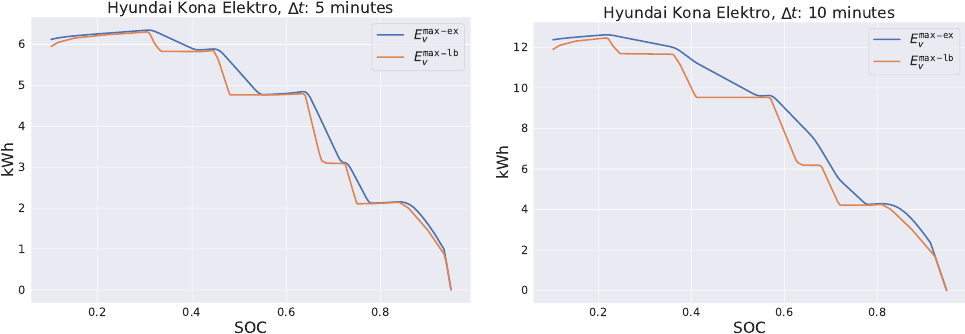
Figure 2. E max v functions for a Hyundai Kona Elektro for ∆ t ∈ { 5,10 }